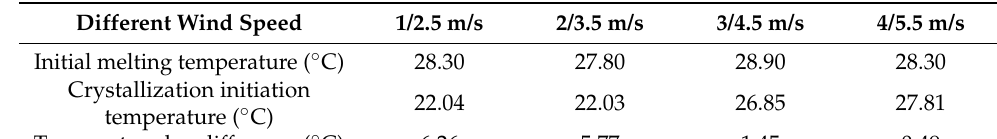
Table 5. Melt initiation temperature and crystallization initiation temperature measured under different wind speed conditions.